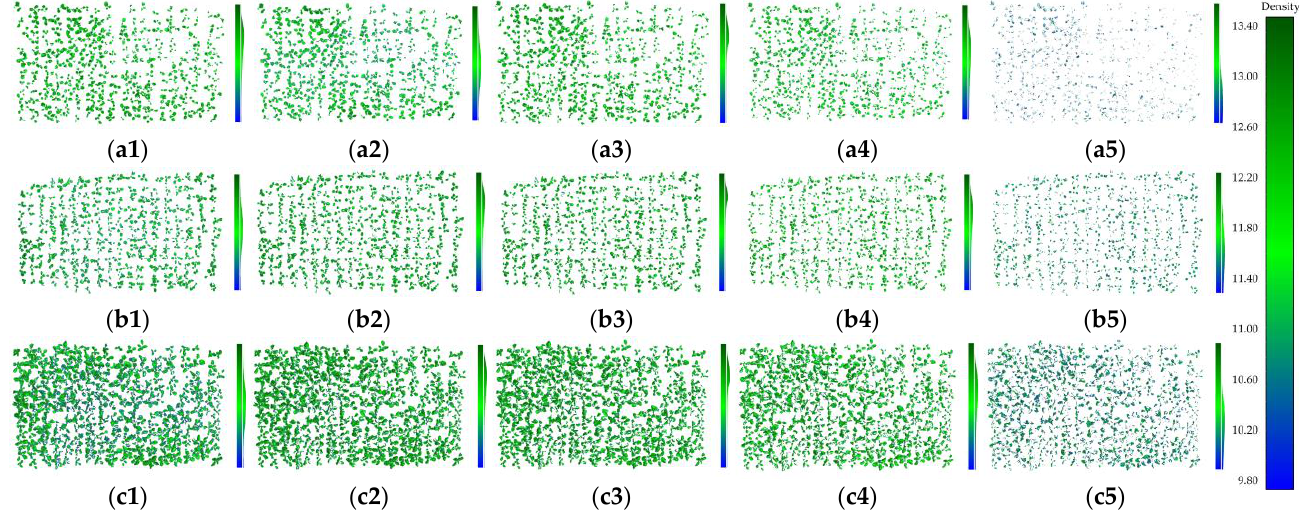
Figure 10. The eight-leaf rapeseed point cloud is processed by the hybrid filter and used as the input of the LA-DT model. Figures ( a1 , b1 , c1) are the rapeseed point cloud with noise, the point cloud without noise, and the output point cloud of the hybrid filter with voxel filter module; the figures ( a2 , b2 , c2 ) are the DTs calculated by LA-DT according to the input point cloud; the figures ( a3 , b3 , c3 ) are the 3D reconstruction meshes output by LA-DT.